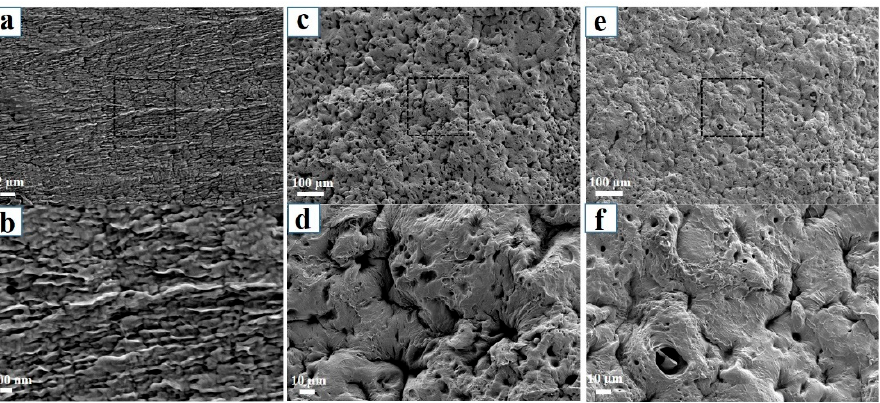
Figure 4. SEM images of the three types of hydrogels. ( a , b ) PVA hydrogel; ( c , d ) PVA/SA hydrogel; ( e , f ) PVA/SA/NaCl hydrogel. The three types of hydrogels were dehydrated by freeze-drying, prior to SEM observation.